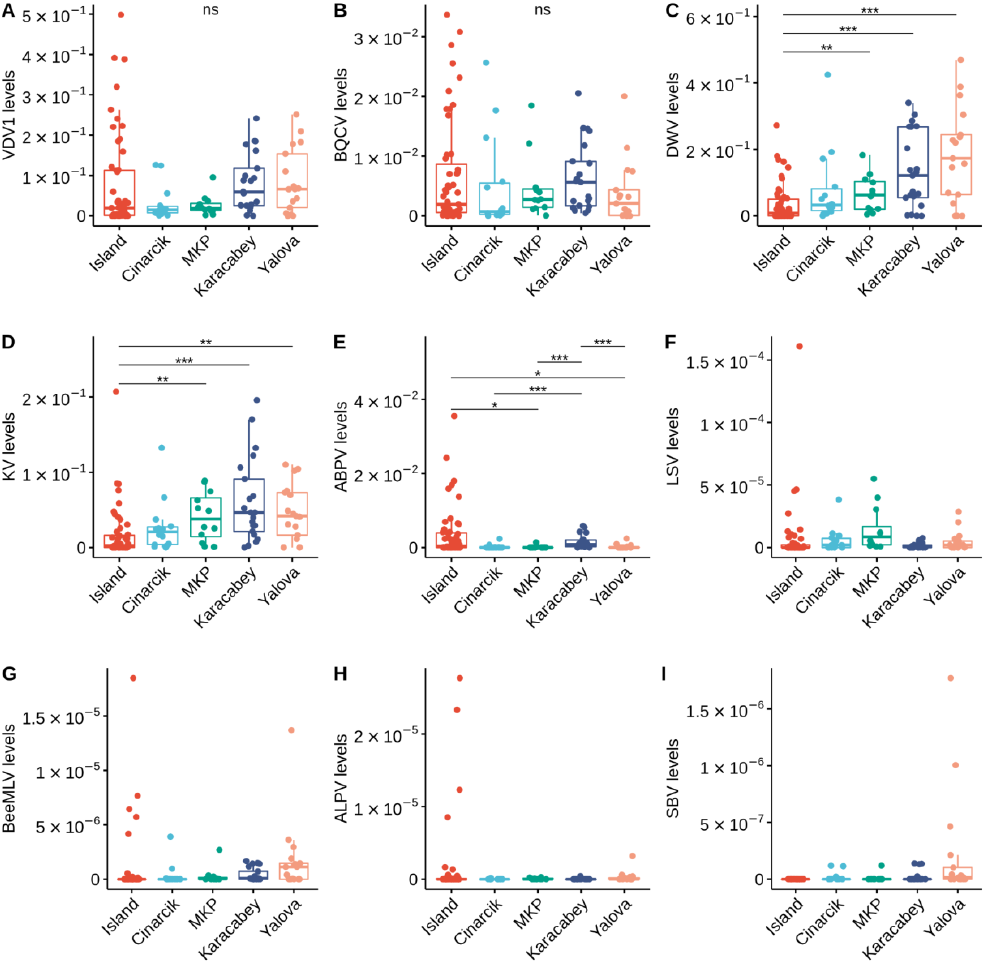
Figure 4. Relative abundance (viral reads/total reads) of VDV1 ( A ), BQCV ( B ), DWV ( C ), KV ( D ), ABPV ( E ), LSV ( F ), BeeMLV ( G ), ALPV ( H ), and SBV ( I ). Each color represents one of the five apiary sampling locations. Statistical significance was determined using the Kruskal–Wallis test followed by Dunn’s test for VDV1, BQCV, DWV, KV, and ABPV. Only significant differences were shown. *** p ≤ 0.001, ** p ≤ 0.01, * p ≤ 0.05, not significant (ns) p > 0.05.